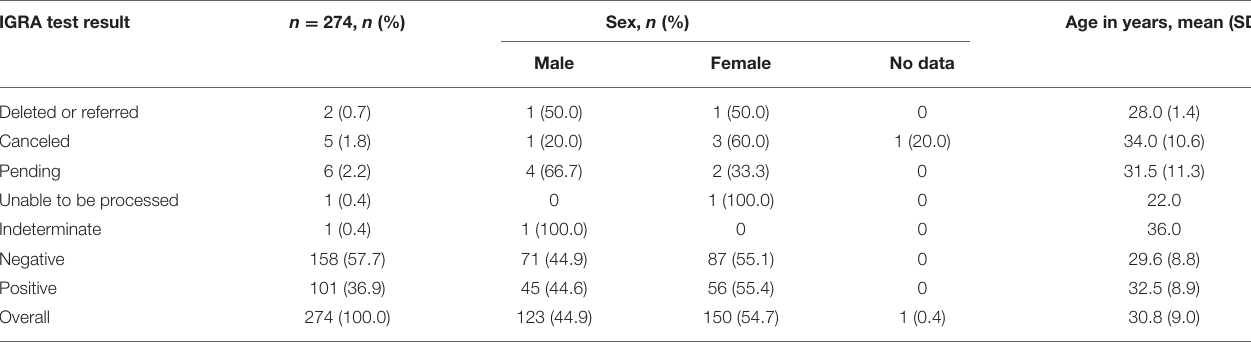
TABLE 1 | IGRA test results in adult refugees from January 2015 to October 2016 at BridgeCare Clinic. IGRA test result